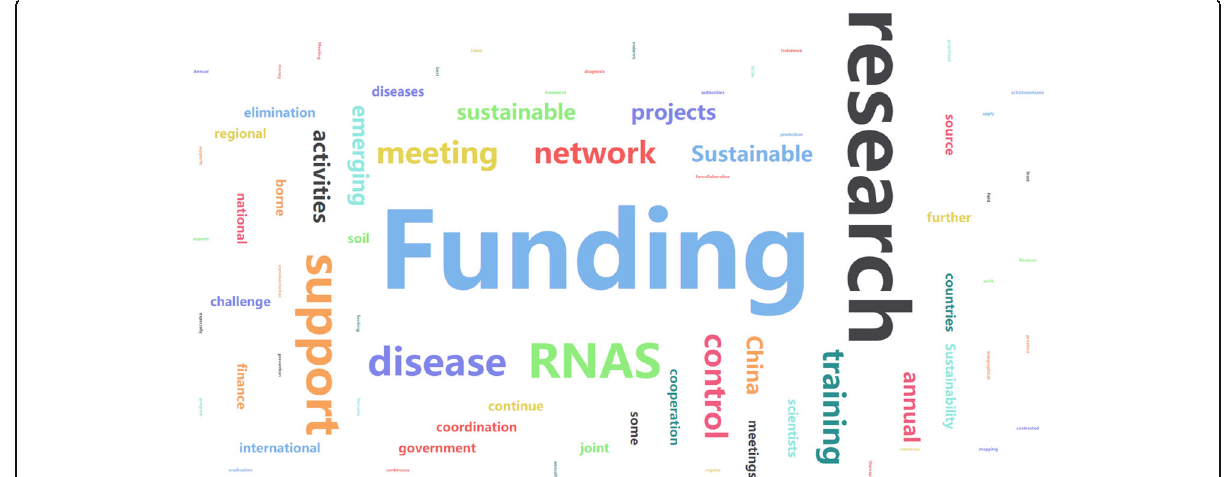
Fig. 3 The highcharts of challenges confronting RNAS + according to the survey participants